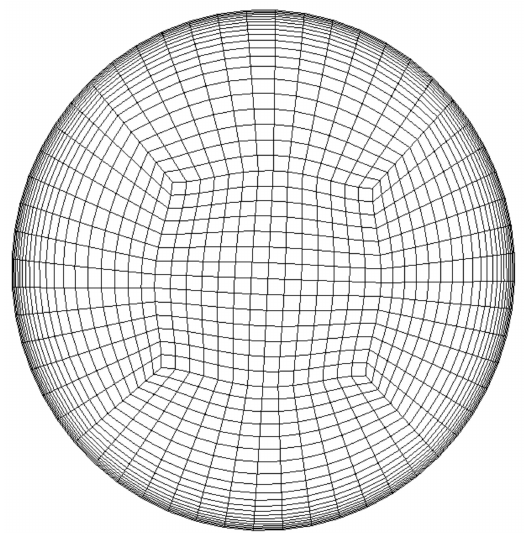
Figure 2. Mesh at pipe domain outlet.